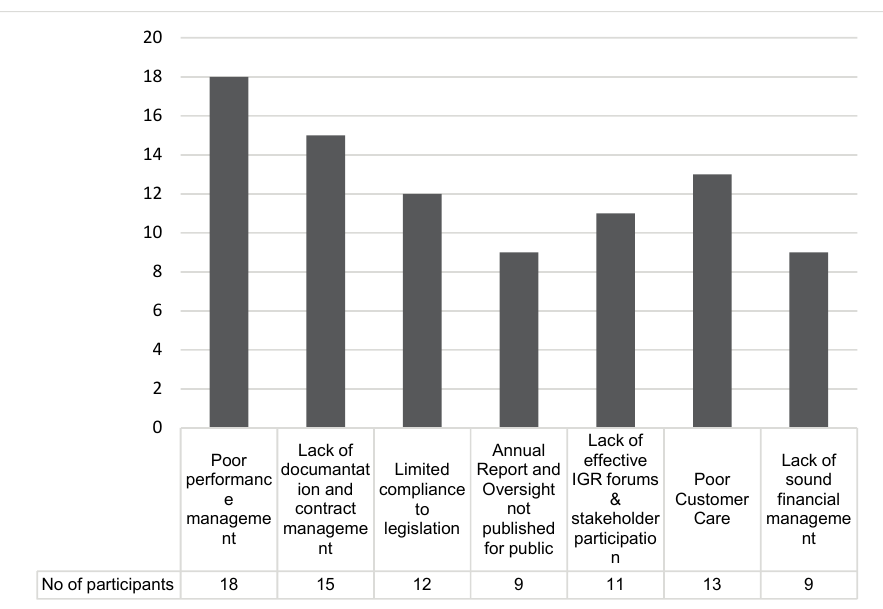
Figure 4: Good Governance through understanding the role of councillors in service delivery and municipal